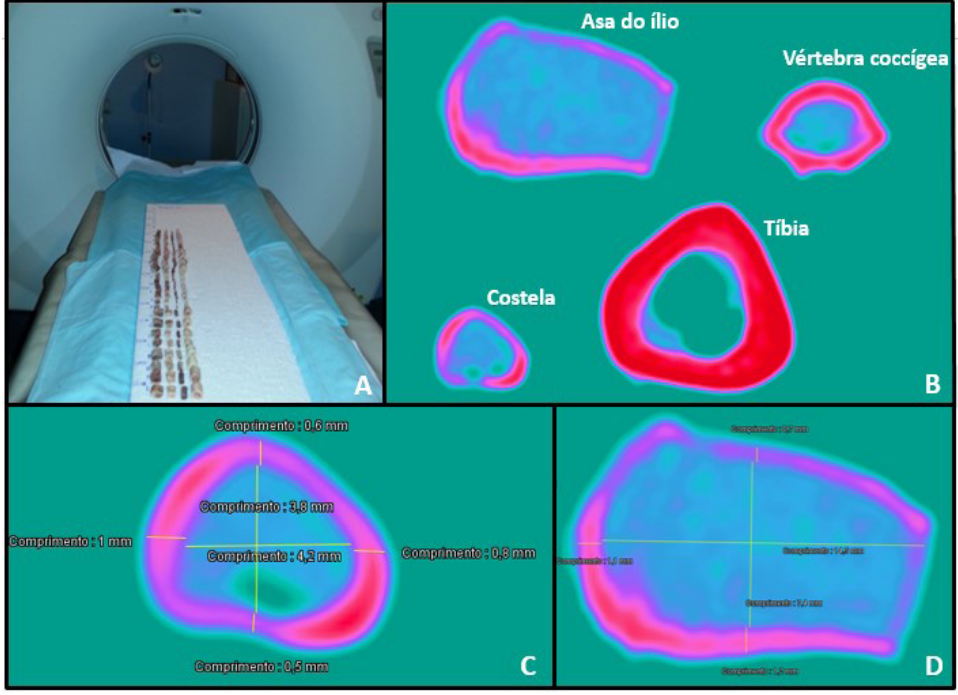
Figura 2. A – Segmentos ósseos posicionados para exame de tomografia computadorizada. B – Secção transversal de cada segmento ósseo. Observar contorno em tom rosa demonstrando a espessura do osso cortical; e em tom azulado a de osso esponjoso (exceto na tíbia). C – Demonstração da mensuração da espessura de